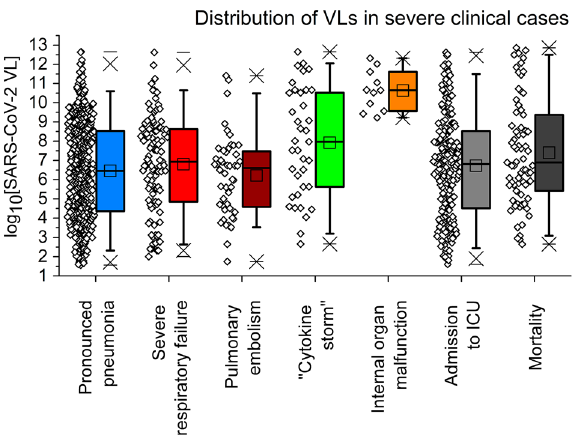
Figure 4. Distribution of SARS-CoV-2 VLs in severe clinical cases: (1) serious viral interstitial pneumonia with X-ray computer tomography opaqueness not less than 15% (469 cases, 5.33%); (2) severe respiratory failure of type 1 [either of PaO 2 /FiO 2 ratio < 280 mmHg OR respiratory rate > 30 min –1 OR SpO 2 < 90% (ARDS score AS > 10–12)] (103 cases, 1.17%); (3) pulmonary embolism (48 cases, 0.55%); (4) immune response dysregulation known as “cytokine storm” (37 cases, 0.42%); (5) internal organ malfunction (11 cases, 0.12%); (6) transfer from general ward to ICU (202 cases, 2.29%); (7) lethal outcome (71 cases, 0.81%). Individual cases and statistical boxes are visualised along each other. Boxes: 25/50/75%. Whiskers: 5/95%. Horizontal lines are maximums/ minimums, crosses stand for 1/99%. Created in OriginPro ver. 9.2.196, https:// www. origi nlab.